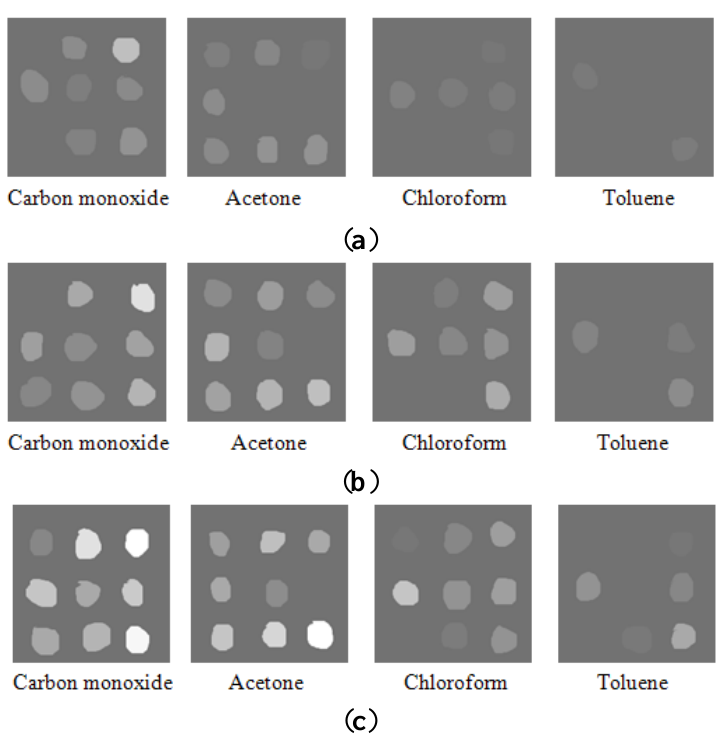
Figure 8. The patterns of carbon monoxide, acetone, chloroform and toluene at different working temperatures. Concentration: 1000 ppm; carrier gas flow rate: 200 mL/min. ( a ) Working temperature: 180 °C; ( b ) Working temperature: 240 °C; ( c ) Working temperature: 280